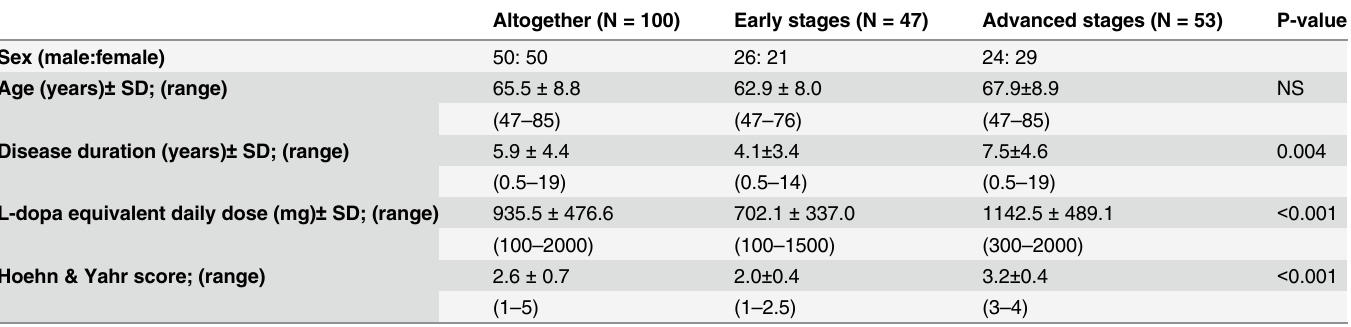
Table 3. Demographic and basic clinical